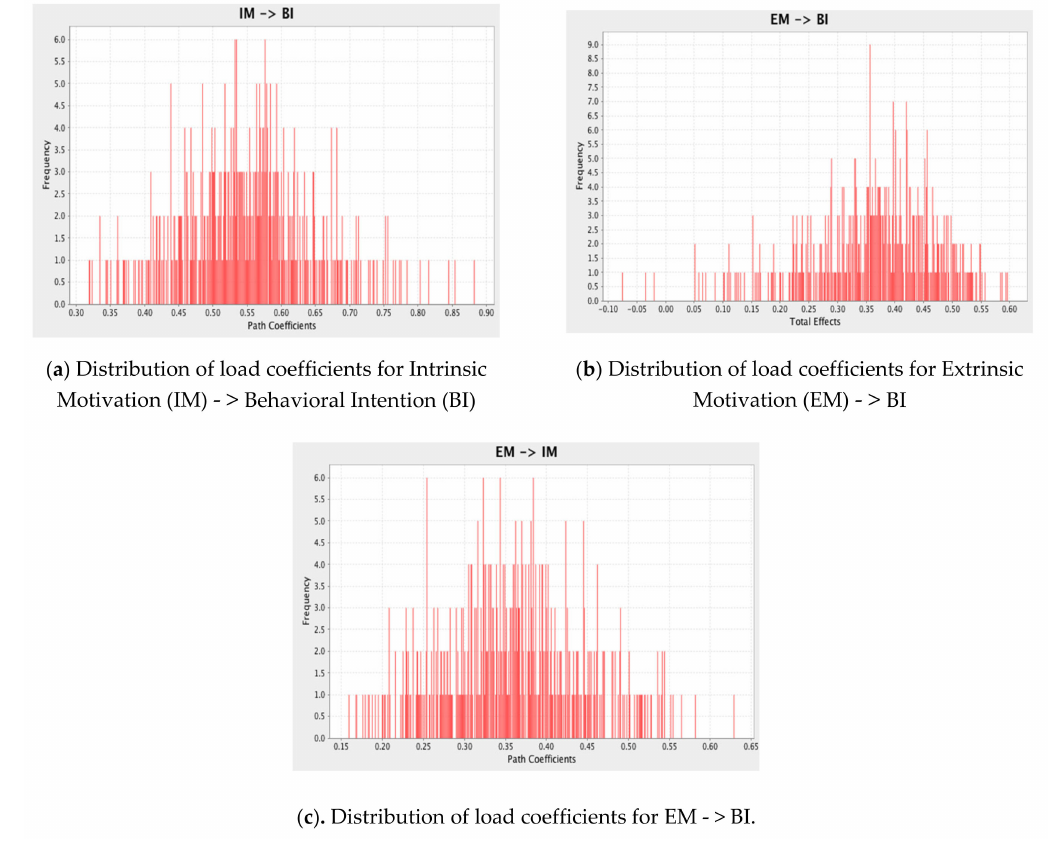
Figure 8. Distribution of load coe ffi